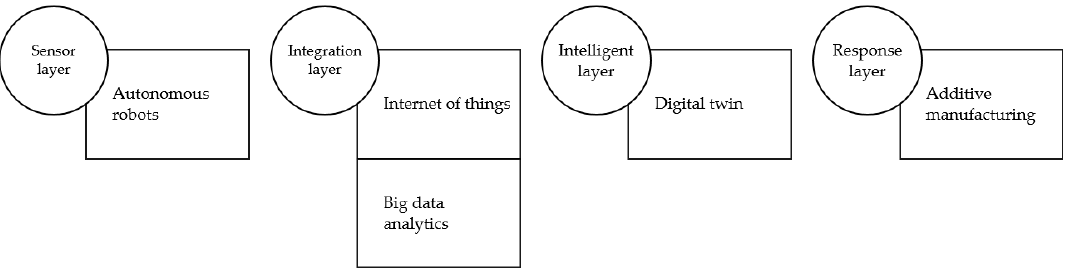
Figure 7. Technology architecture and classification.